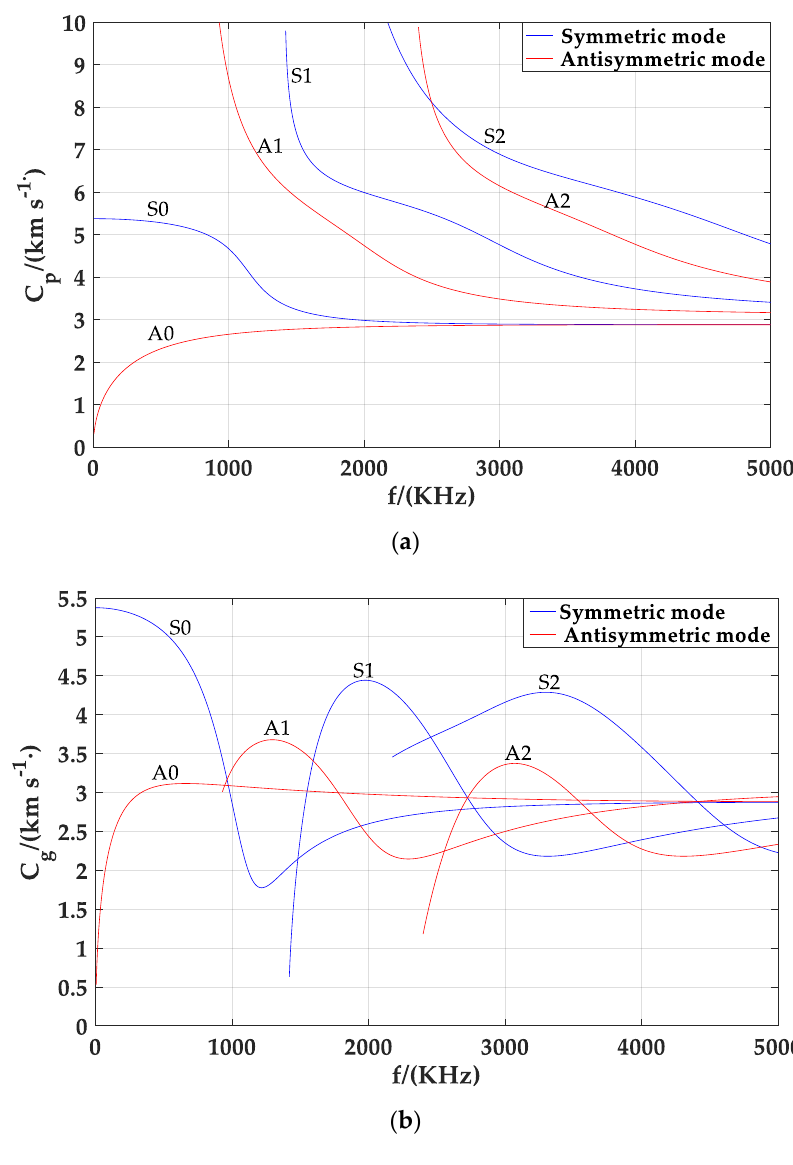
Figure 2. Dispersion curve in 2 mm aluminum plate: ( a ) Phase velocity dispersion curve; ( b ) group velocity dispersion curve.